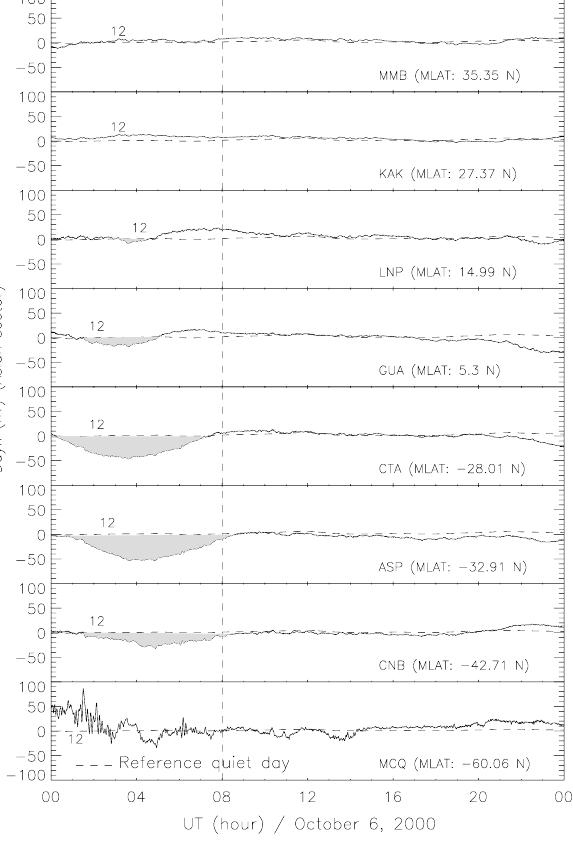
Fig. 7. Latitudinal variation of the Ddyn disturbance in the Asian sector, on 6 October 2000.